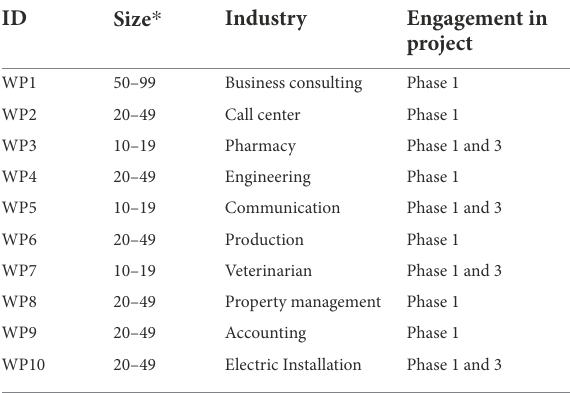
TABLE 3 Participant